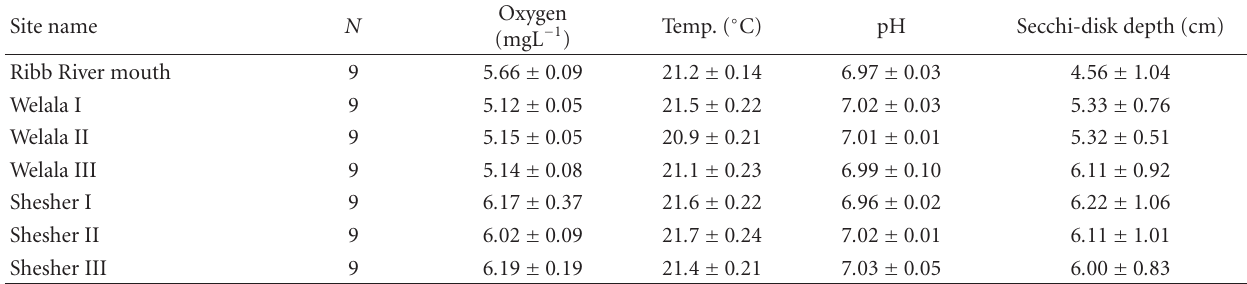
Table 2: Mean ± SE (Standard Error) values of oxygen concentration, temperature, pH, and Sechi-disk depth at the sampling sites. N refers to number of samplings.